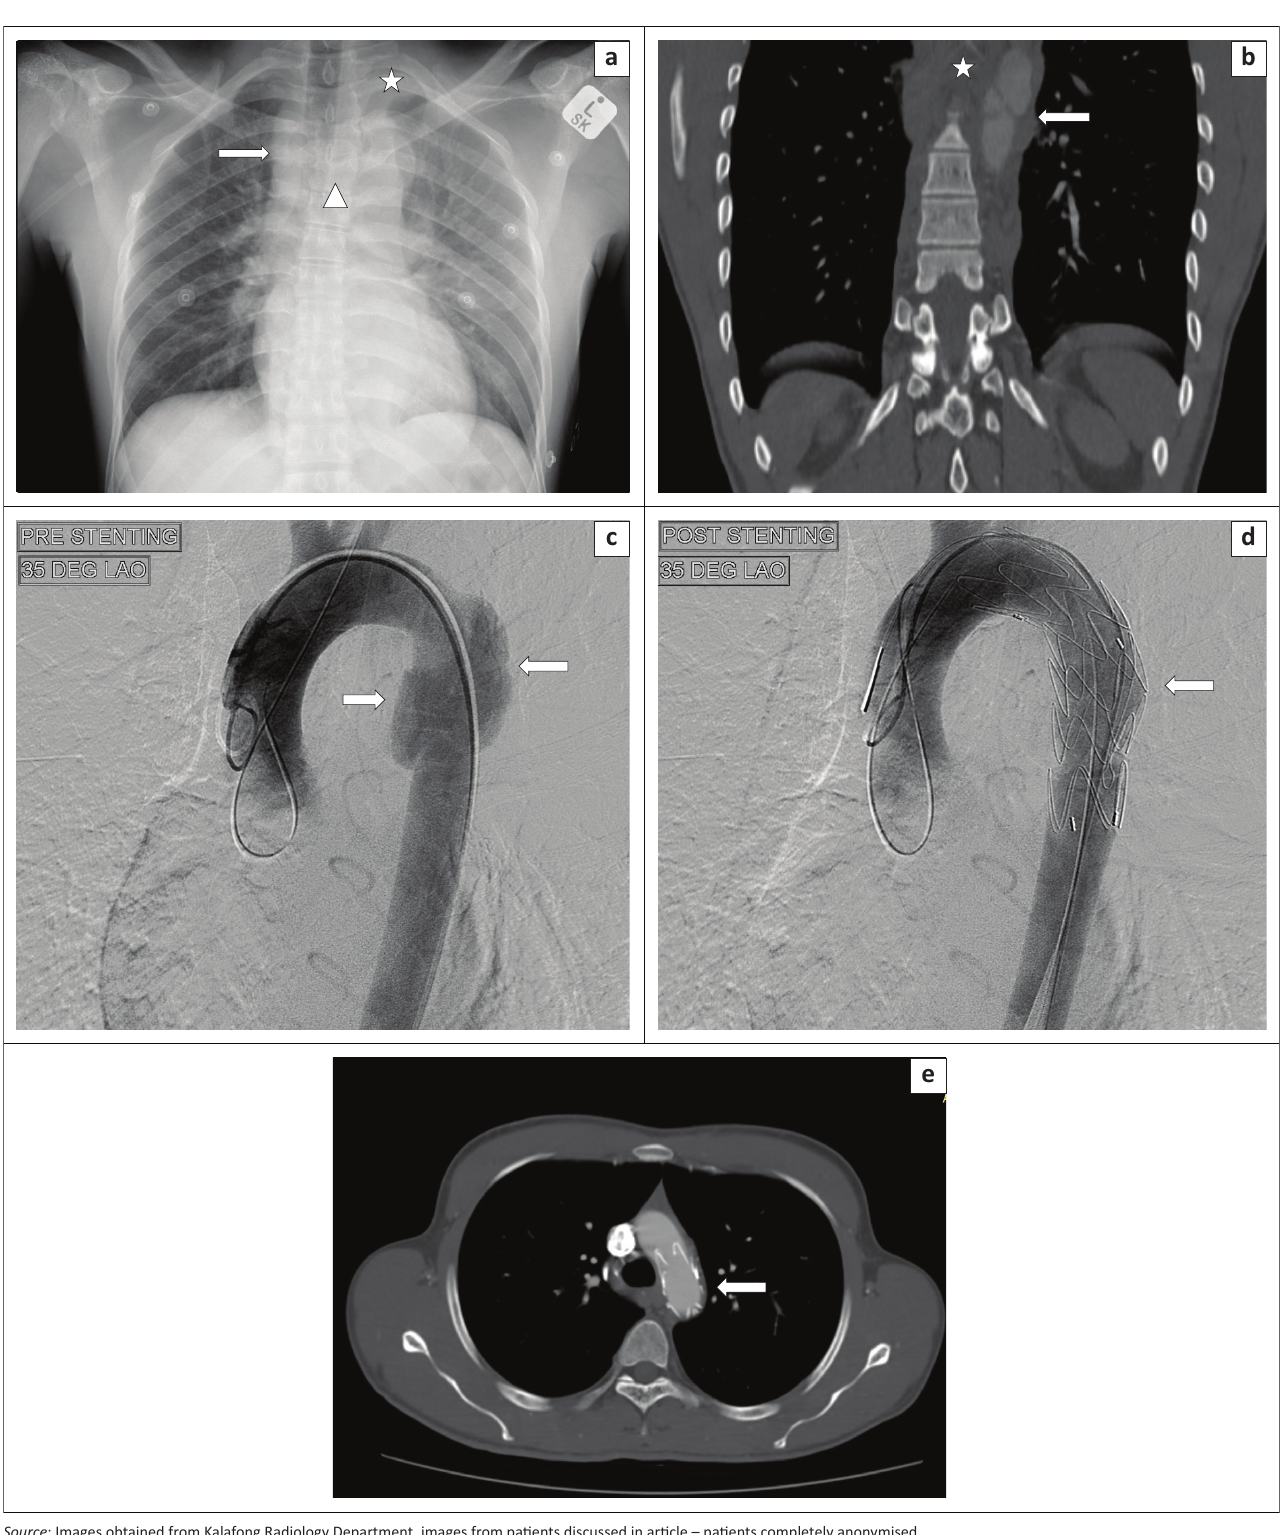
FIGURE 1: (a) Chest radiography in a 36-year-old male patient involved in a motor vehicle accident. There is widening of the mediastinum (arrow) with a left apical pleural cap (star) and veiling of the left lung field in keeping with a left haemothorax. There is depression of the left main bronchus (triangle), and the silhouette of the aortic knuckle is maintained. (b) Computed tomography angiography demonstrating a mediastinal haematoma (star) and a type 2 aortic injury with an intimal flap and a pseudoaneurysm (arrow). (c) Digital subtraction angiogram image prior to stenting delineating the false aneurysm (arrows) beyond the origin of the left subclavian artery. (d) Digital subtraction angiogram image post successful endovascular aneurysm repair with the stent in place (arrow). (e) Follow-up computed tomography angiography indicates the stent in place with no complications